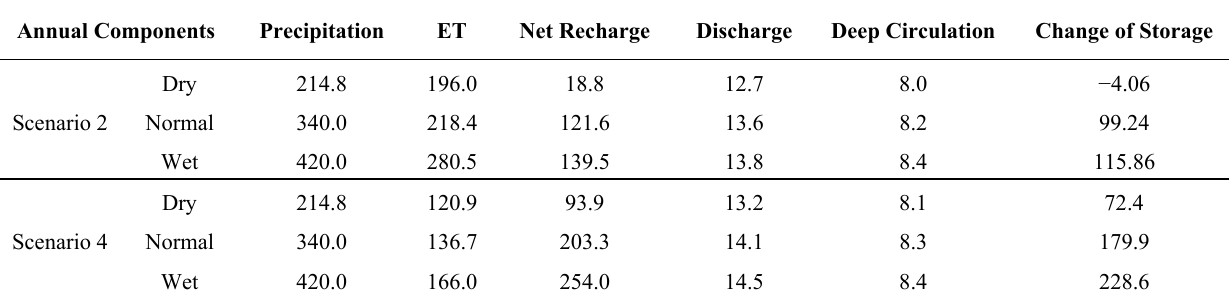
Table 5. Comparison of simulated annual water balance components for scenarios 2 and 4 under different hydrological years